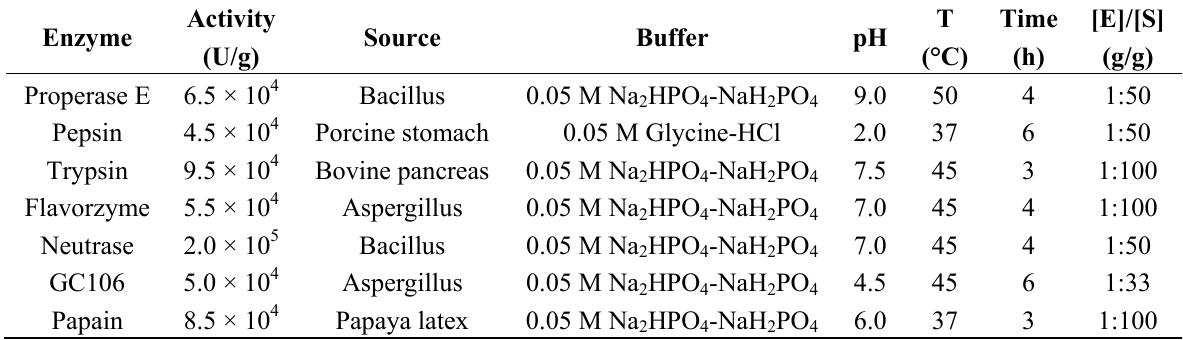
Table 2. The optimum conditions (based on the manufacturer recommendations) for seven proteases hydrolyzing tilapia frame